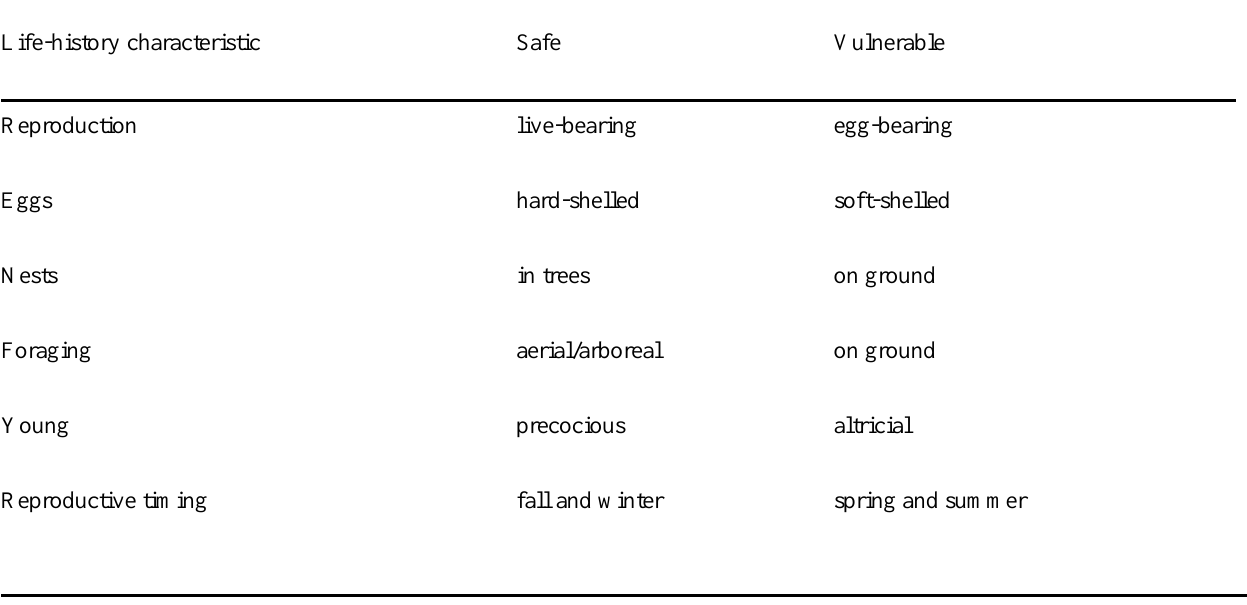
Table 1. Elements of the ecologically-based hazard index for assessing the relative risk of different life- history characteristics to fire ant impacts. Fire ant impacts on wildlife, and characteristics that lead to vulnerability to fire ant impacts, are reviewed in Allen et al.